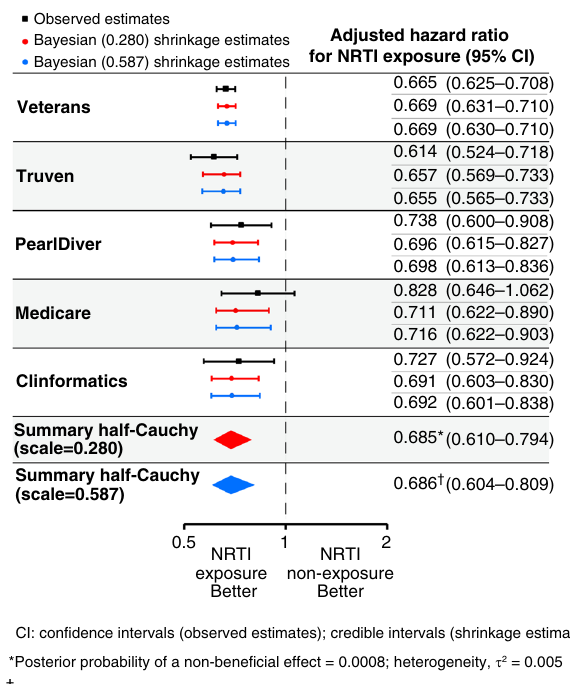
CI: confidence intervals (observed estimates); credible intervals (shrinkage estimates) *Posterior probability of a non-beneficial effect = 0.0008; heterogeneity, τ 2 = 0.005 †Posterior probability of a non-beneficial effect = 0.0017; heterogeneity, τ 2 = 0.006 Fig. 2 Bayesian meta-analysis of incident diabetes. Hazard ratios based on a Cox proportional-hazards model and adjusted for the confounding variables listed in Supplementary Tables 5, 7, 9, 11, and 13 were estimated separately for each database and are shown in black along with their 95% con fi dence intervals. A Bayesian meta-analysis was performed using a random-effects model and a weakly informative hierarchical half-Cauchy prior distribution 85,86 for between-study variance with the assumption that it was unlikely for the between-study hazard ratios to vary by more than 3-fold (scale = 0.280). A sensitivity analysis to the choice of the prior by assuming that it was unlikely for the between-study hazard ratios to vary by more than 10-fold was also performed (scale = 0.587). The Bayesian shrinkage estimates and the summary estimates of the adjusted hazard ratio of incident diabetes for NRTI exposure (ever versus never), along with the 95% credible intervals, are shown in red (scale = 0.280) and blue (scale = 0.587). The dashed vertical line denotes a hazard ratio of 1.0, which represents no difference in risk between nucleoside reverse- transcriptase inhibitor (NRTI) exposure and non-exposure. The estimates of heterogeneity ( τ 2 ) and the posterior probabilities of a non-bene fi cial effect for each model are shown below the